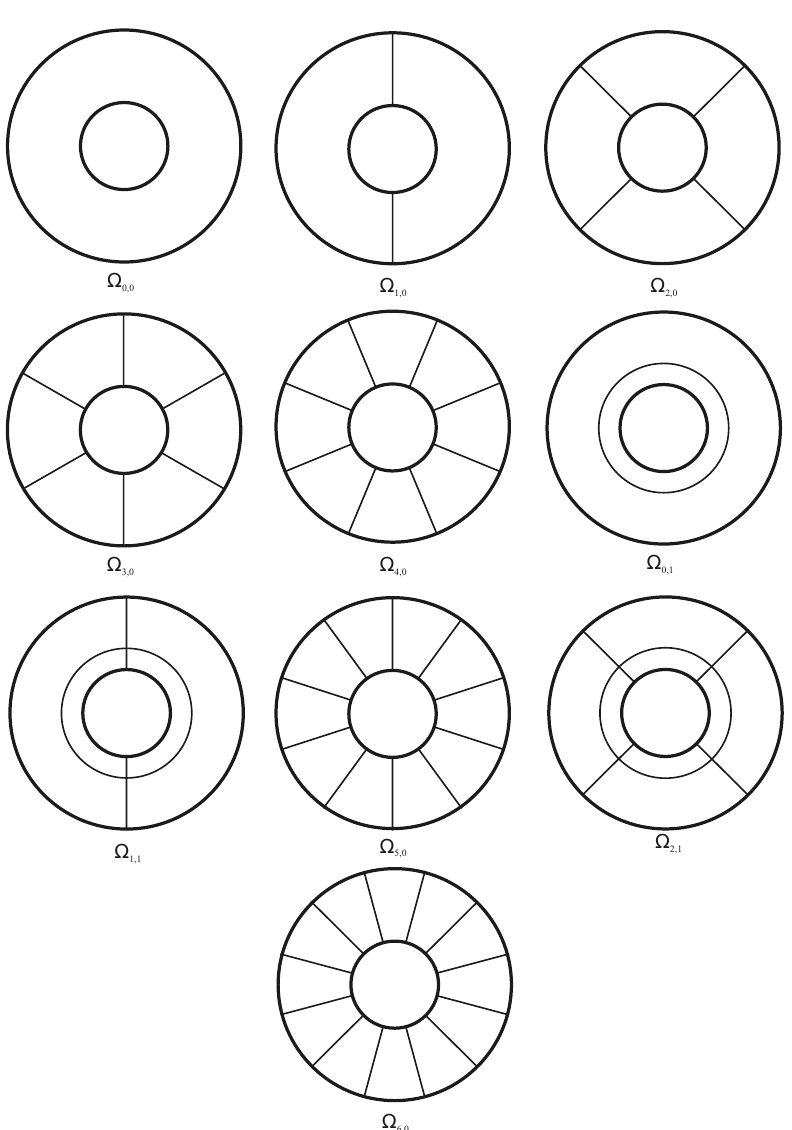
Fig. 6. For first ten nodal lines of S - S plates when α = β = 0.4, e r = g r = 5.0, R = 0.5, K f =